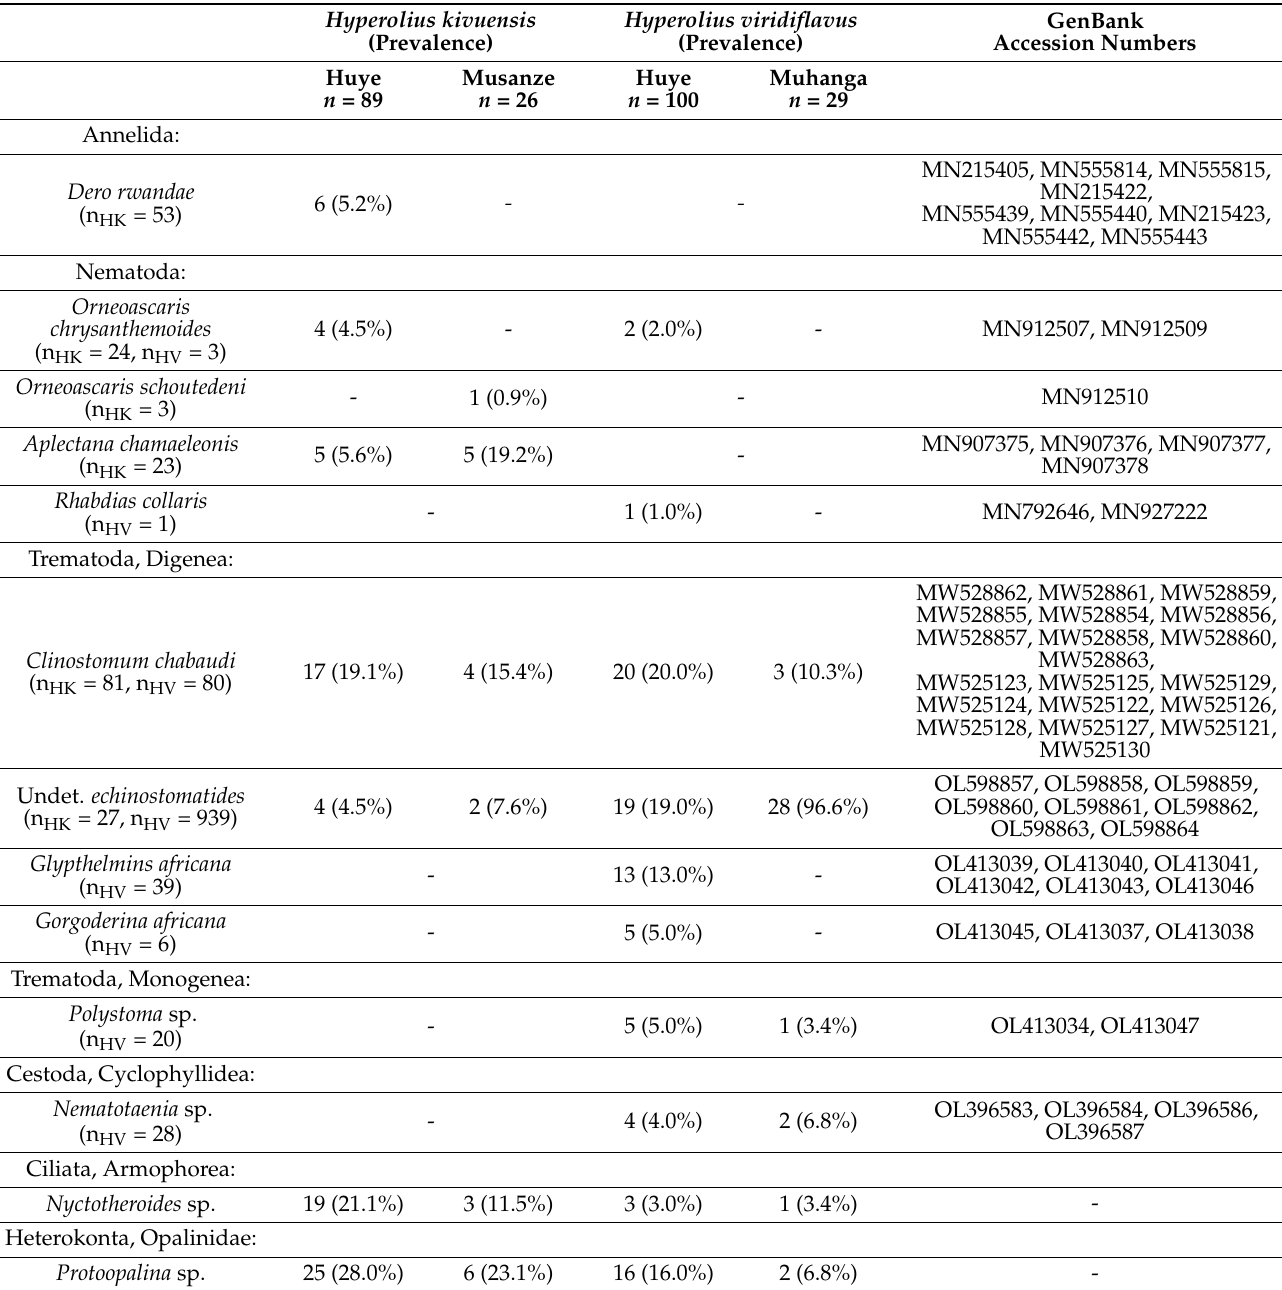
Table 2. Species list of metazoan endoparasites and protozoan endocommensals infesting reed frogs in Rwanda. Prevalence (presented as the absolute number of parasitized frog hosts and as ratio by the total number examined), total number of individuals per parasite species in H. kivuensis (n HK ) and H. viridiflavus (n HV ), and accession number of sequences uploaded to the GenBank data